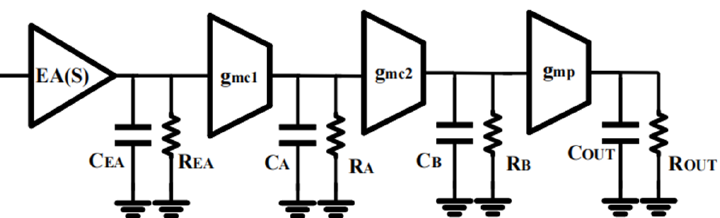
Figure 8. Small-signal model.